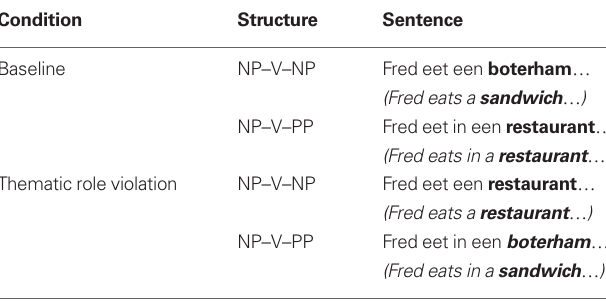
Table 1 | Example of one quartet of the thematic role violations and their baseline in the original Dutch version and their English translation (depicted in